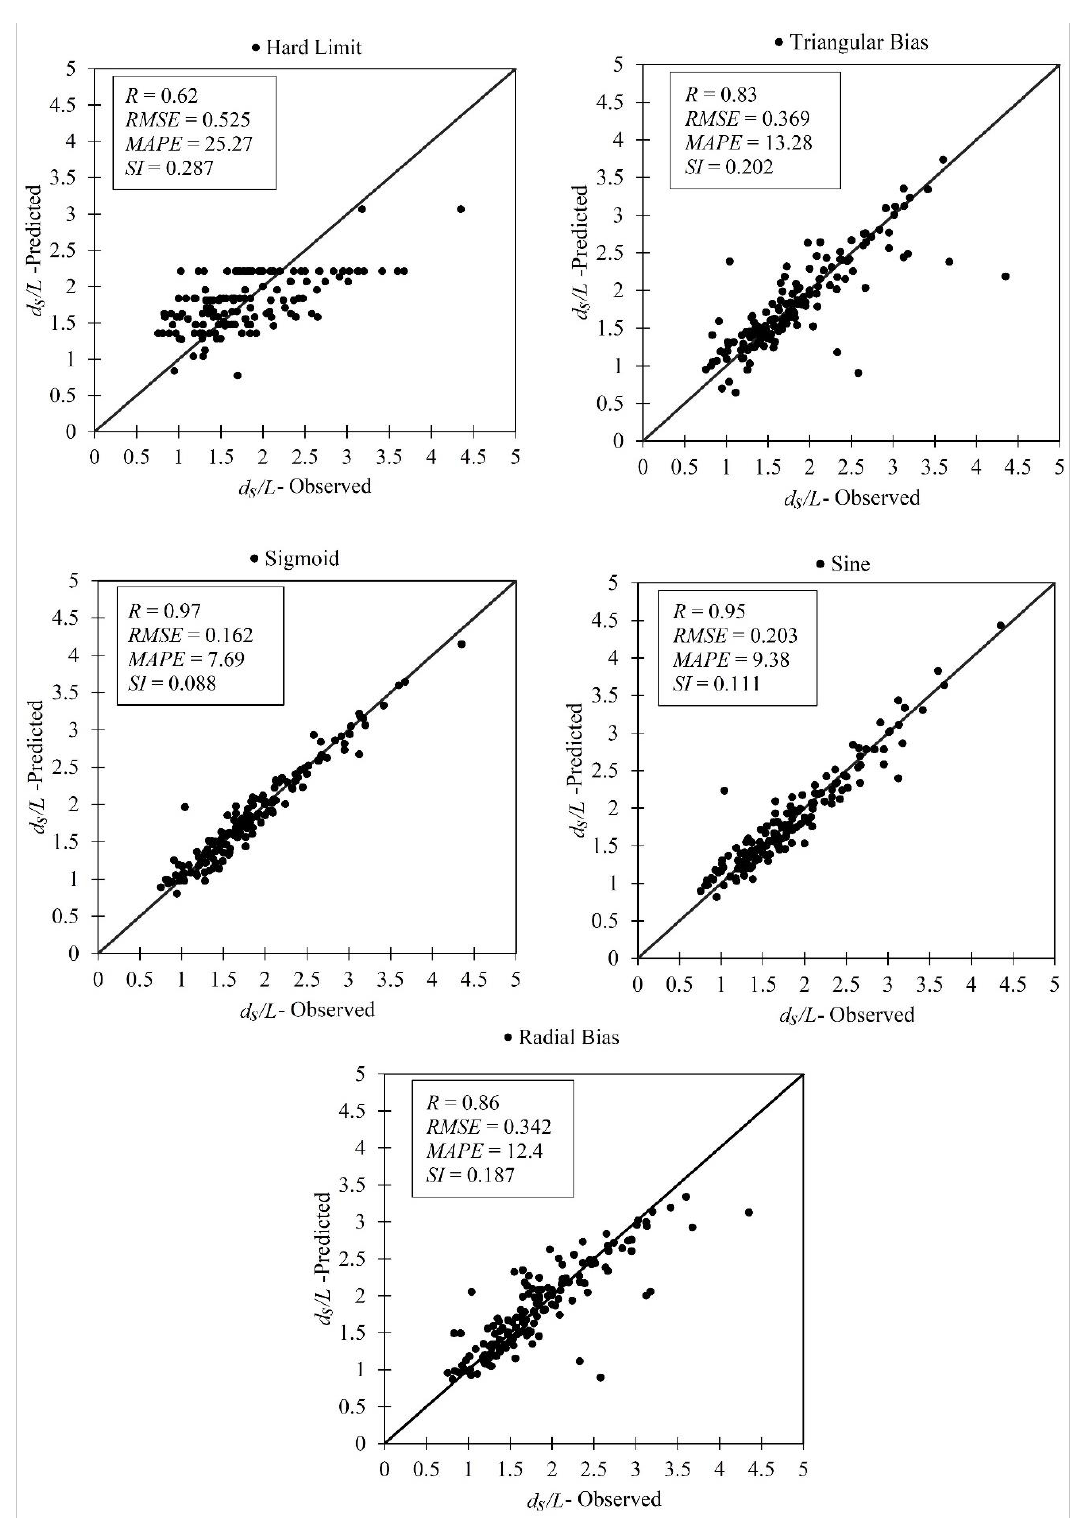
ff erent ELM activation Figure 4. Scatter plot of different ELM activation functions. Figure 4. Scatter plot of di